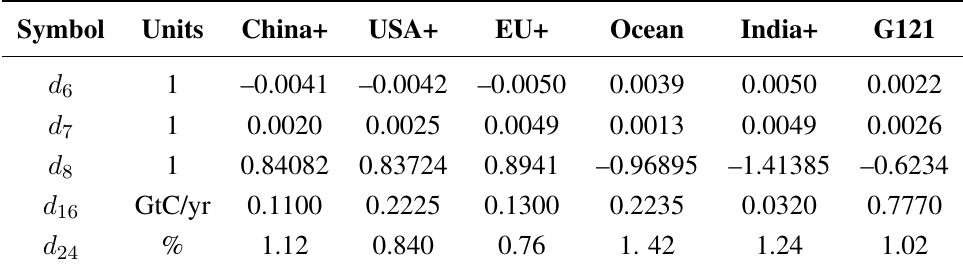
Table 8. Region dependent financial